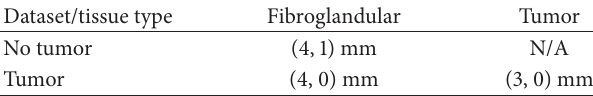
Table 5: Spatial accuracy of the reconstructed